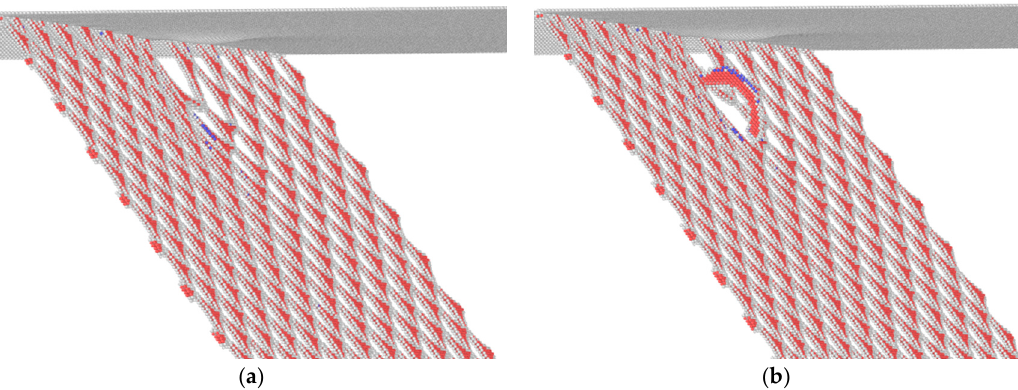
Figure 4. Dislocation nucleation mechanisms at the 4° twist boundary. The gray at the top is the indentation surface. ( a) The network of intrinsic GB dislocations deforms first; and ( b ) the dislocation lines in the network combine to form the bulk crystal dislocation half loop, which then expands into the crystal. The details of the nucleation mechanism are shown in Figure 5.